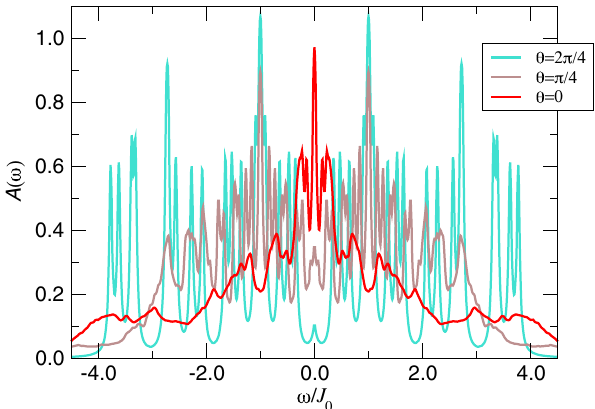
FIG. 9. Spectral function A ð ω Þ calculated for the giant vortex geometry with N ¼ 28 and coupling constants ð J; K Þ ¼ J 0 ð cos θ ; sin θ Þ taken to interpolate between the fully interacting and noninteracting